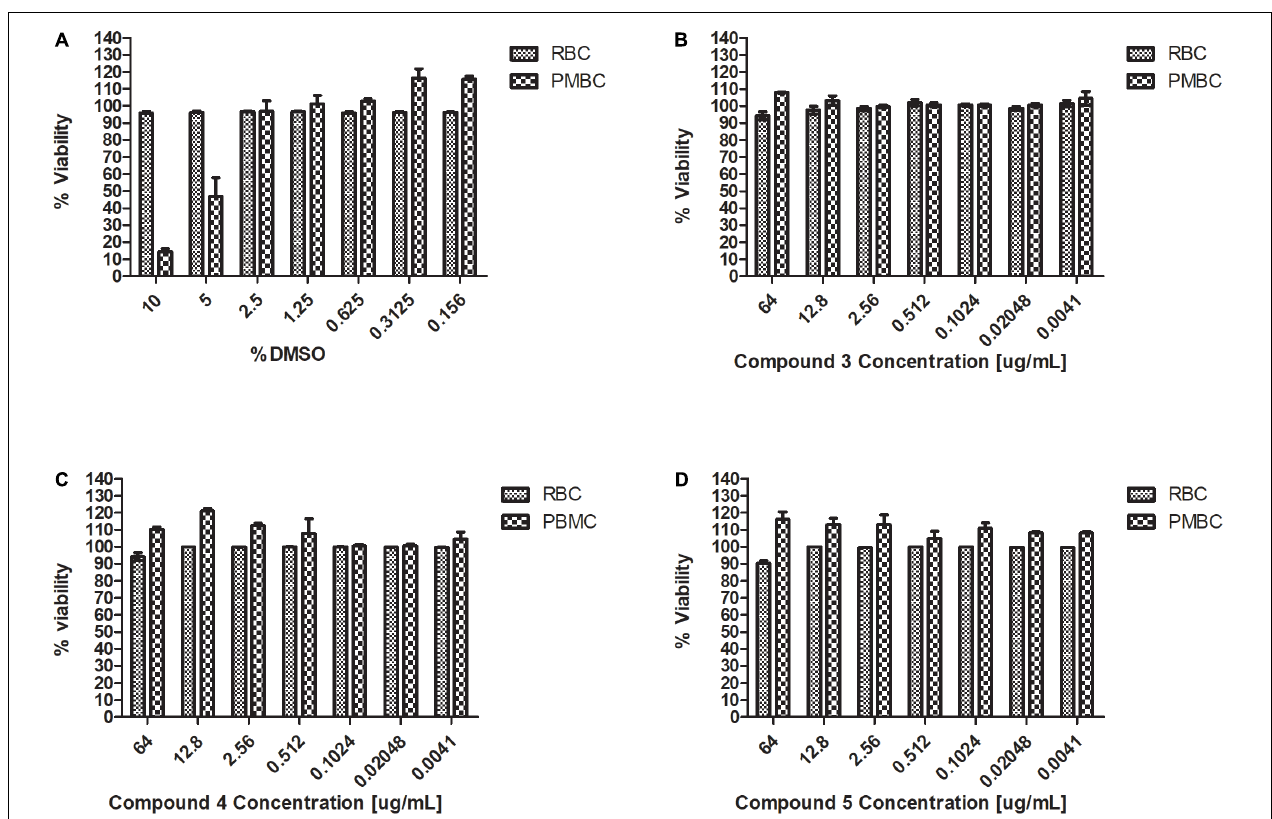
FIGURE 3 | Haemolysis and cytotoxicity effects of Teixobactin derivatives at various concentrations (A) Viability (%) of RBCs and PBMCs treated with DMSO; (B) Viability (%) of RBCs and PBMCs treated with compound 3; (C) Viability (%) of RBCs and PBMCs treated with compound 4; (D) Viability (%) of RBCs and PBMCs treated with compound 5. The experiment was performed in triplicate ( n = 3). The error bars indicate the standard deviation. One-way ANOVA followed by Dunnett’s test was performed to determine the significance relative to the RBC and PMBC ( P < 0.05).